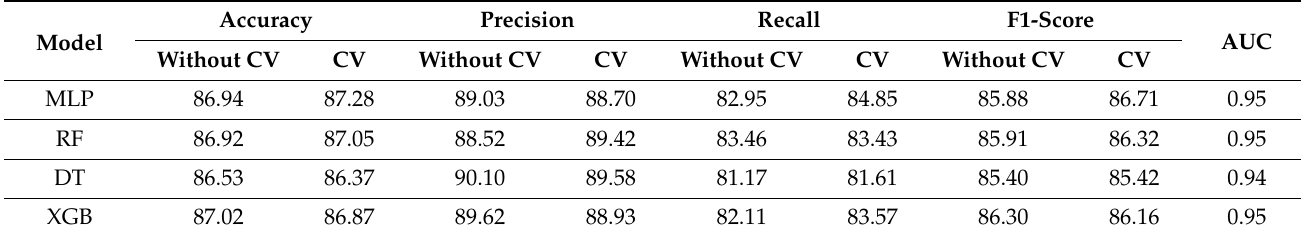
Table 5. The evaluation metrics resulting from different